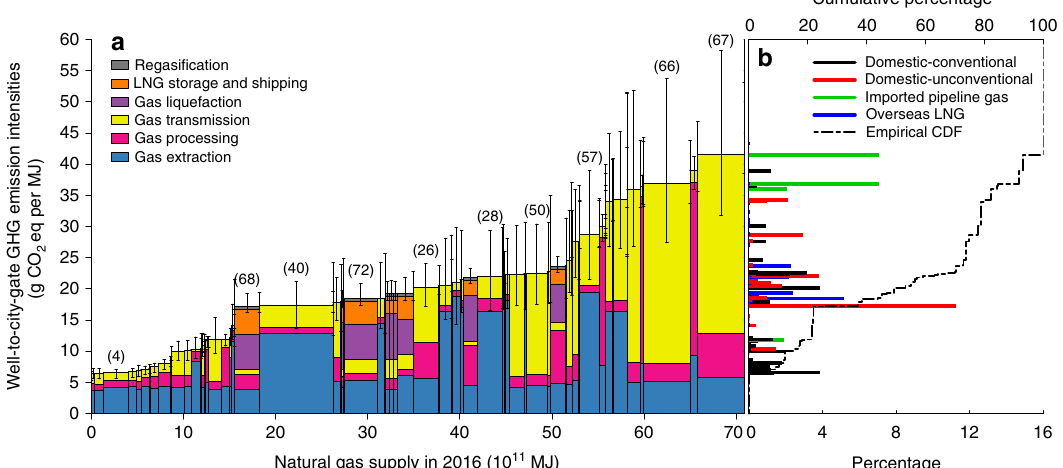
Fig. 2 Well-to-city-gate GHG intensity supply curve of natural gas for China in 2016. a The GHG intensity supply curve with emission breakdowns for individual processes. Bars with numbers in parentheses on top are the top 10 gas fi elds with the largest supply in 2016. The numbers in parentheses are their corresponding gas fi eld numbers in Table 1 and Fig. 1. Error bars represent the 90% CI of the estimates with Monte Carlo simulation of uncertain parameter inputs (see Supplementary Discussion 1 and 2 for details). b Empirical probability mass function and empirical cumulative probability function (CDF). Different colors in the empirical probability mass function indicate different categories of gas sources. GHG intensities in the fi gure are based on GWP 100 . Source data are provided in a Source Data fi